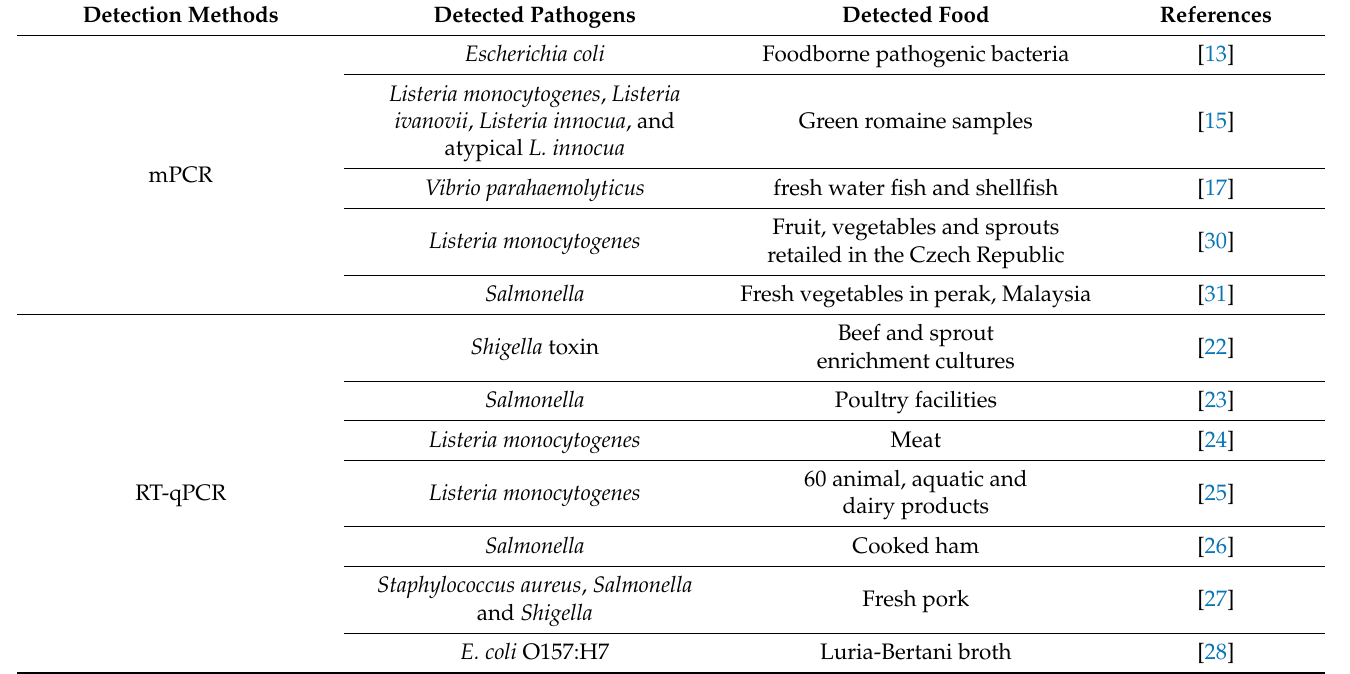
Table 1. Application of PCR technology in the detection of foodborne